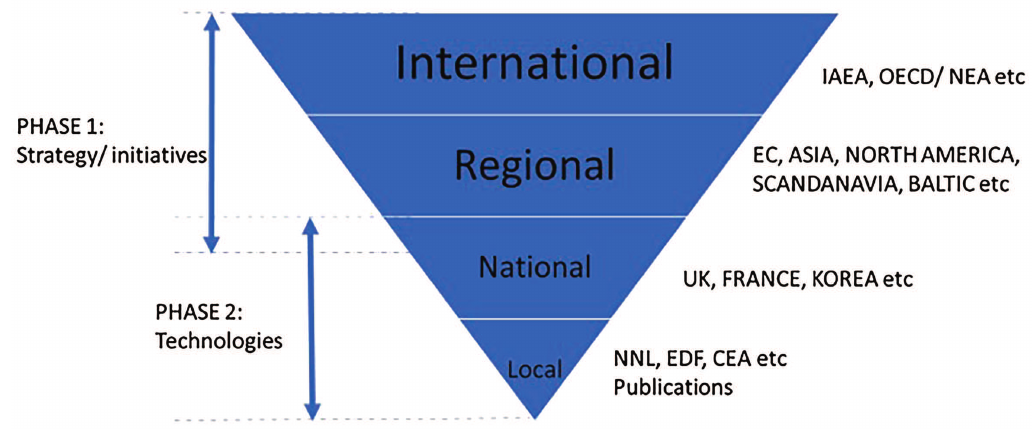
Fig. 4. Scales of the state of the art